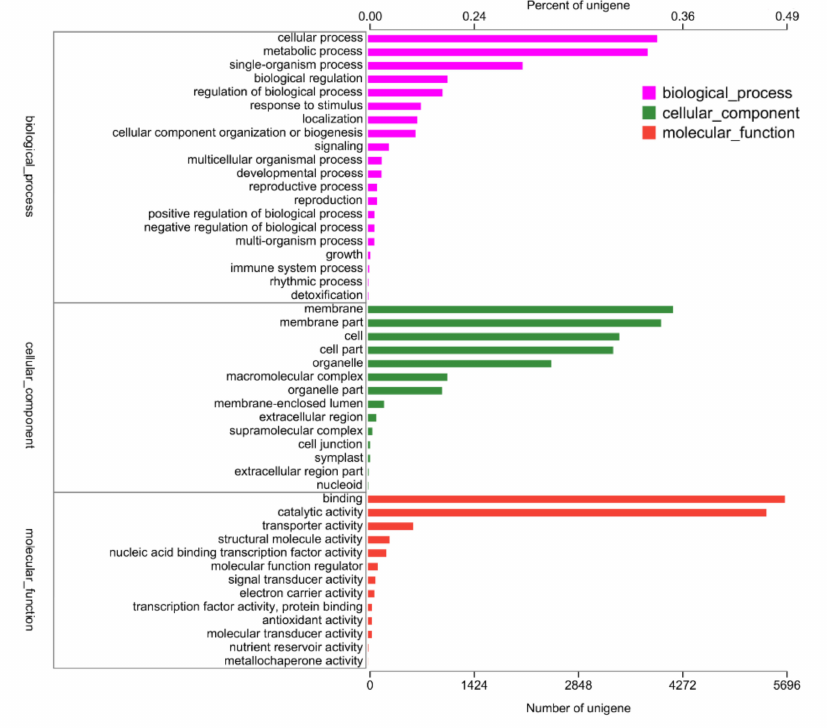
Figure 3. Functional classification of GO enrichment for assemble unigenes of M. azedarach .